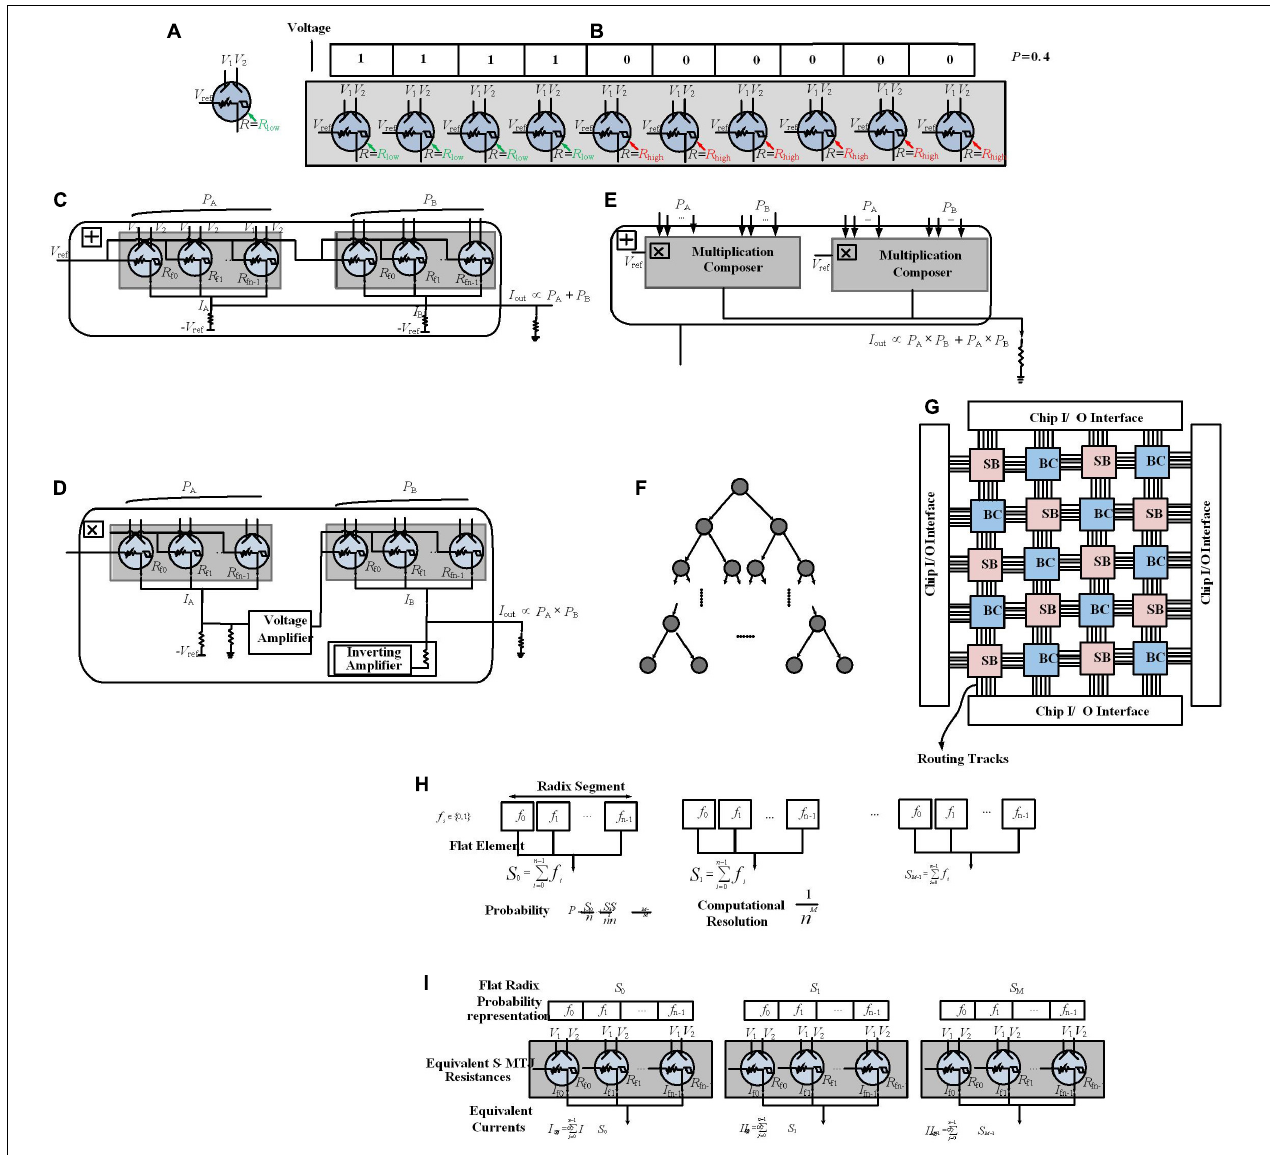
FIGURE 5 | Probability encoding via Strain-switched Magneto-Tunneling Junction (S-MTJ) device. (A) A S-MTJ Device. (B) Probability data encoding by spatially distributed digits, and two-state S-MTJs for physically equivalent representations. Probability value P = 0.4 has been encoded with 10 digits (resolution of